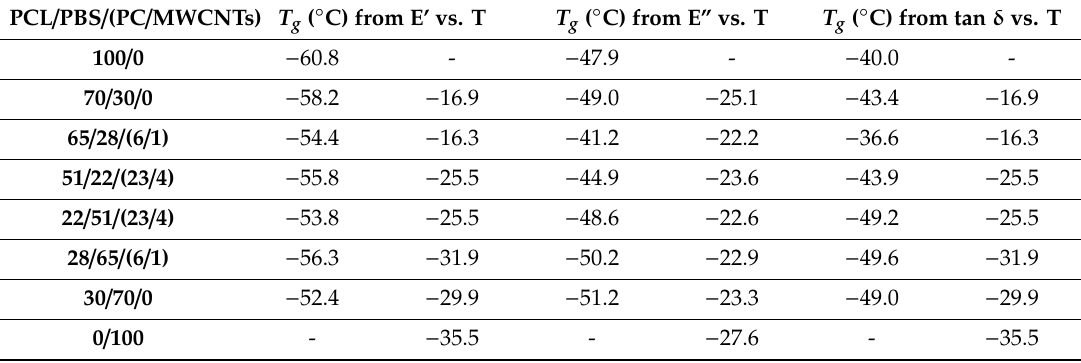
Transition temperatures ( T g ) obtained from E’ , E” and tan δ curves for all the investigated